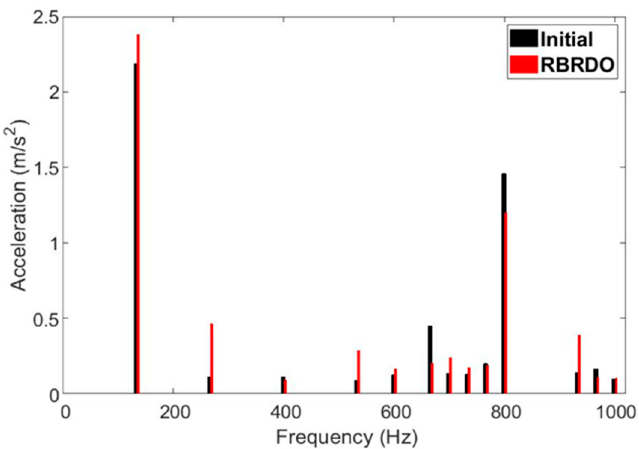
Figure 14. Comparison of vibration analysis results of initial BLDC motor and RBRDO.